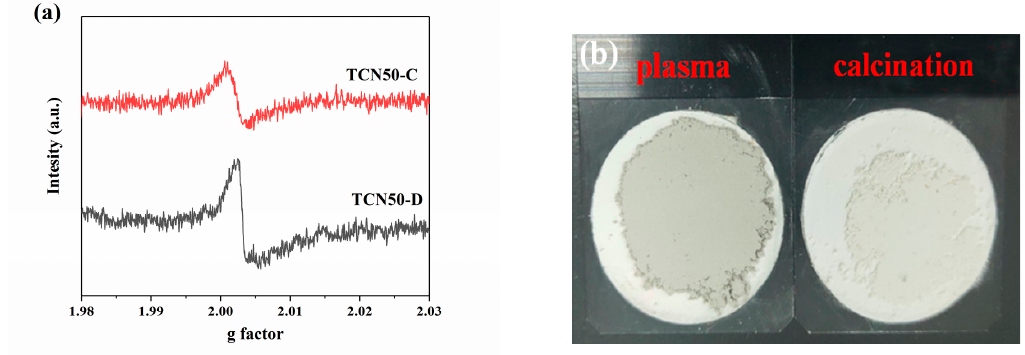
Figure 3. ( a ) EPR spectra of TCN50-C and TCN50-D samples, ( b ) images of TiO 2 prepared by plasma and calcination.